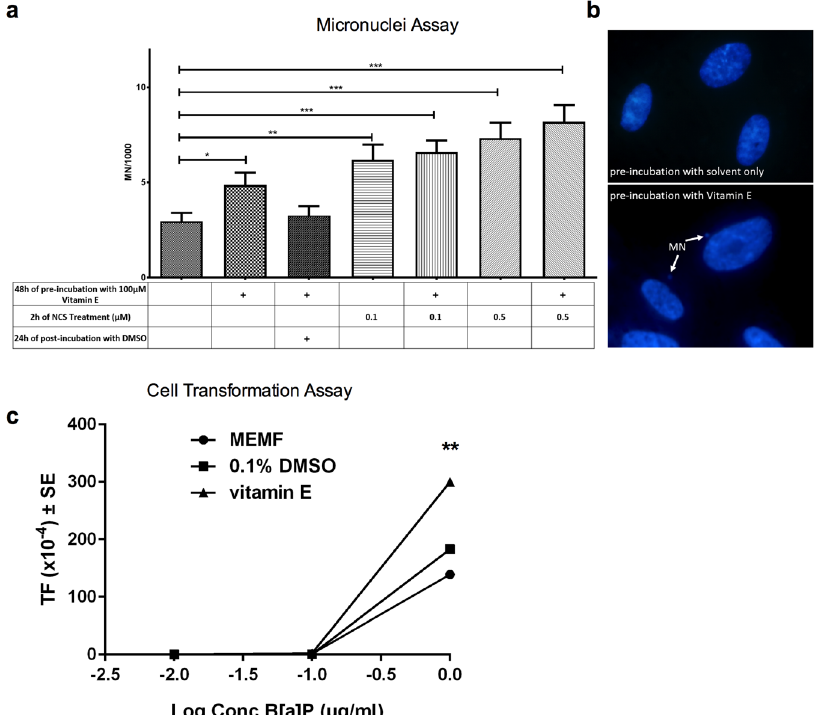
Figure 3. Vitamin E promotes DNA damage and cell transformation. ( a ) Human fibroblasts (IMR90) were treated with vitamin E (100 µ M) and/or neocarzinostatin (NCS, used as positive control), 0.1 µ M or 0.5 µ M. DMSO was applied in control samples since it was used to dilute vitamin E. After 48 h of pre-incubation with vitamin E the cells were treated with NCS for 2 h and finally with MEM for 24 h (see Table below the histogram). The micronuclei were scored counting at least 1,000 nuclei per sample. A significance difference was observed between control and vitamin E-treated samples ( P < 0.05) and between control and NCS-treated samples ( P < 0.01 and P < 0.001). Bars represent the mean ( ± SE). All data were analyzed by the unpaired t-test * P < 0.05; ** P < 0.01; *** P < 0.001. ( b ) An example of DAPI-stained nuclei of cells pre-incubated with DMSO (control, upper) and DMSO plus vitamin E (below). Arrows indicate micronuclei. ( c ) BALB/c3T3 cells were seeded for cellular transformation assay (CTA), maintained in culture for 24 h and exposed to minimum essential medium (MEM) supplemented with 10% fetal bovine serum (MEMF), 0.1% DMSO or 100 µ M vitamin E for 24 h. Then cells were treated with B[a]P (final concentrations 0.01 - 0.1 - 1 µ g/ml) for 48 h. Four weeks after seeding, cells were fixed, stained and scored for transformed foci. The type III foci number was determined in each plate, according to the established scoring criteria. Statistical analysis of foci distribution was performed by the Mann–Whitney unpaired t-test. The transformation frequency (TF) was calculated on the basis of the foci number divided by the clonal efficiency (ACE) observed in the cytotoxicity assay performed concurrently. ACE represented the number of cells surviving chemical treatment. Cells treated with vitamin E and then with B[a] P at concentrations leading to cell transformation showed a significant increase in TF ( P < 0.01, Exact Poisson test). (Control vs groups of each